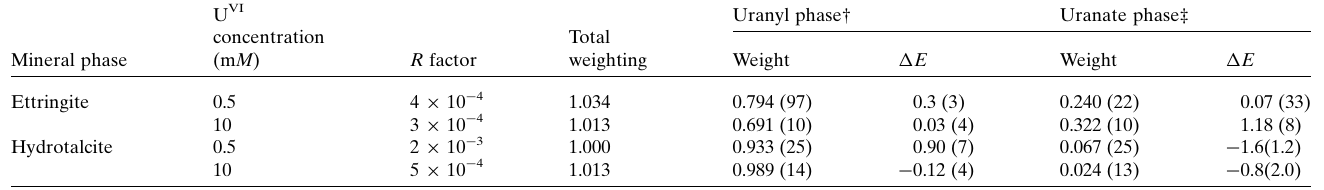
Table 4 Weighted fraction of signal contributions in the XANES region, determined using linear combination fitting, for U VI -contacted ettringite and hydrotalcite systems.